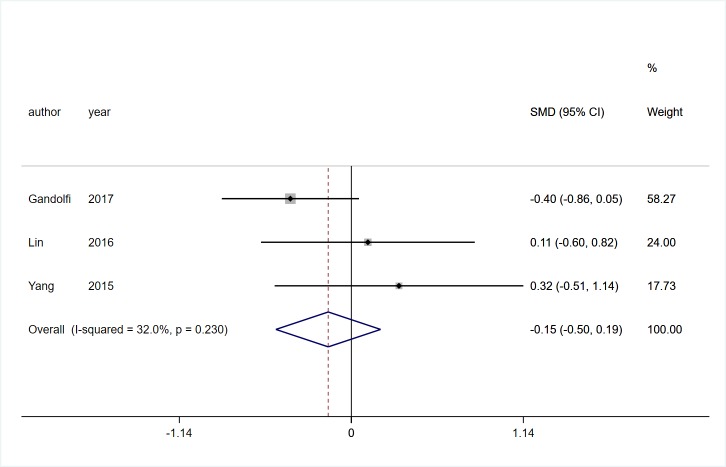
Forest plot of DGI.